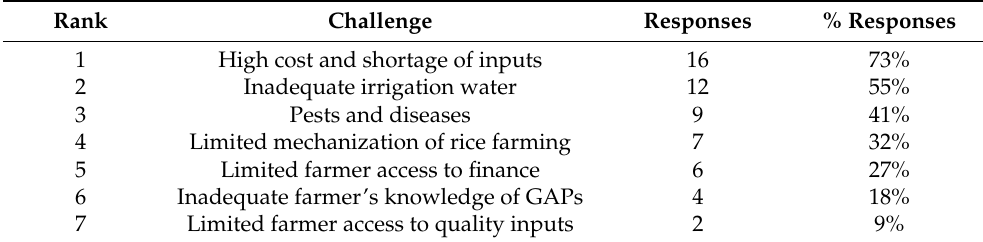
Table 2. Farmers’ ranking of the challenges that they face in rice cultivation in the Doho rice scheme. The responses were drawn from 22 respondents using open-ended